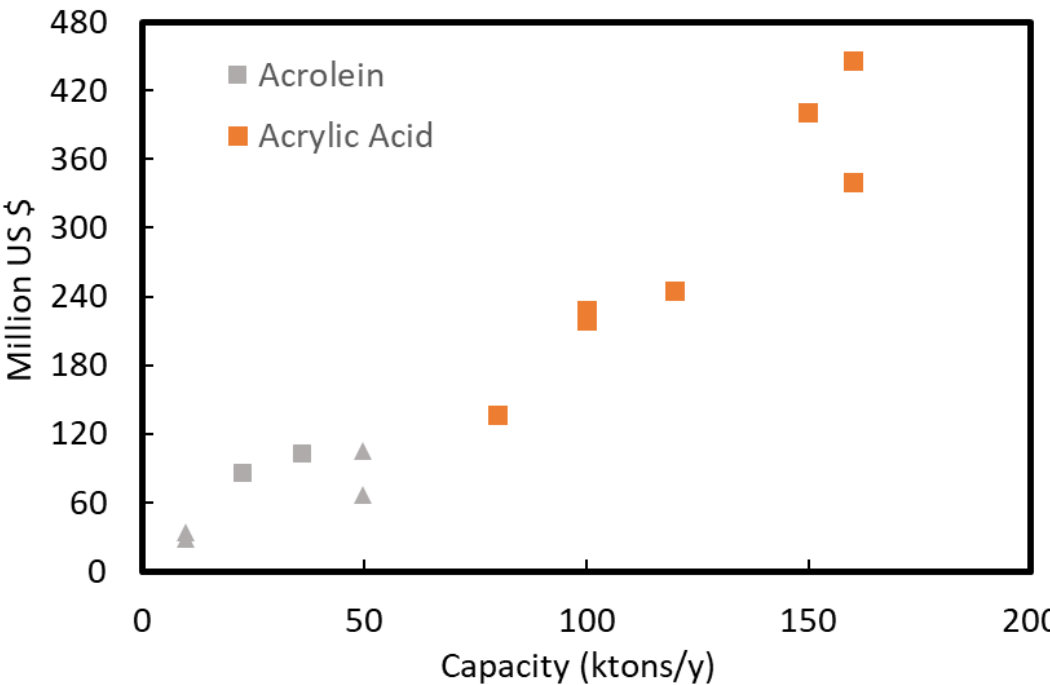
Figure 6. Scaled investment (2019, France) versus original plant capacity, with historical data of acrylic acid acrolein pro-